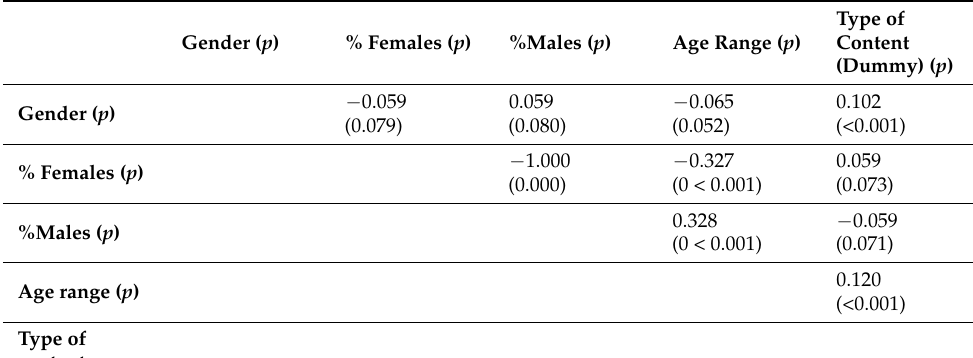
Table 6. Correlational study. Source: own elaboration.